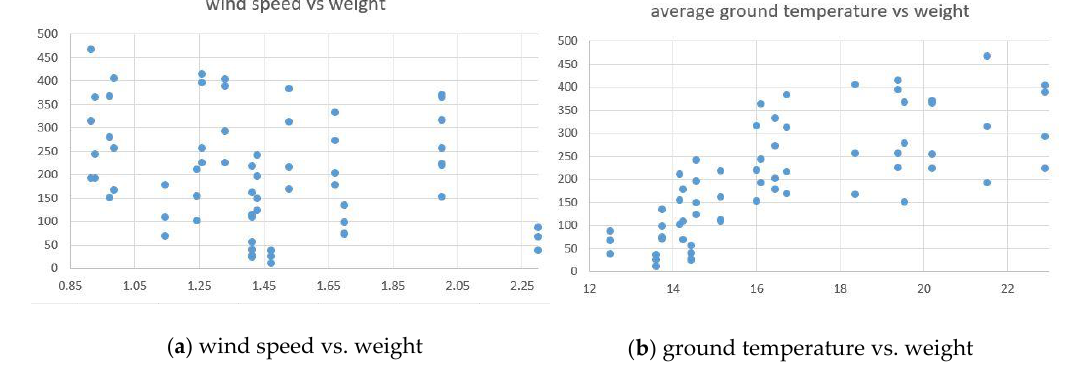
Figure 2. Line graphs of weight and six environmental factors.